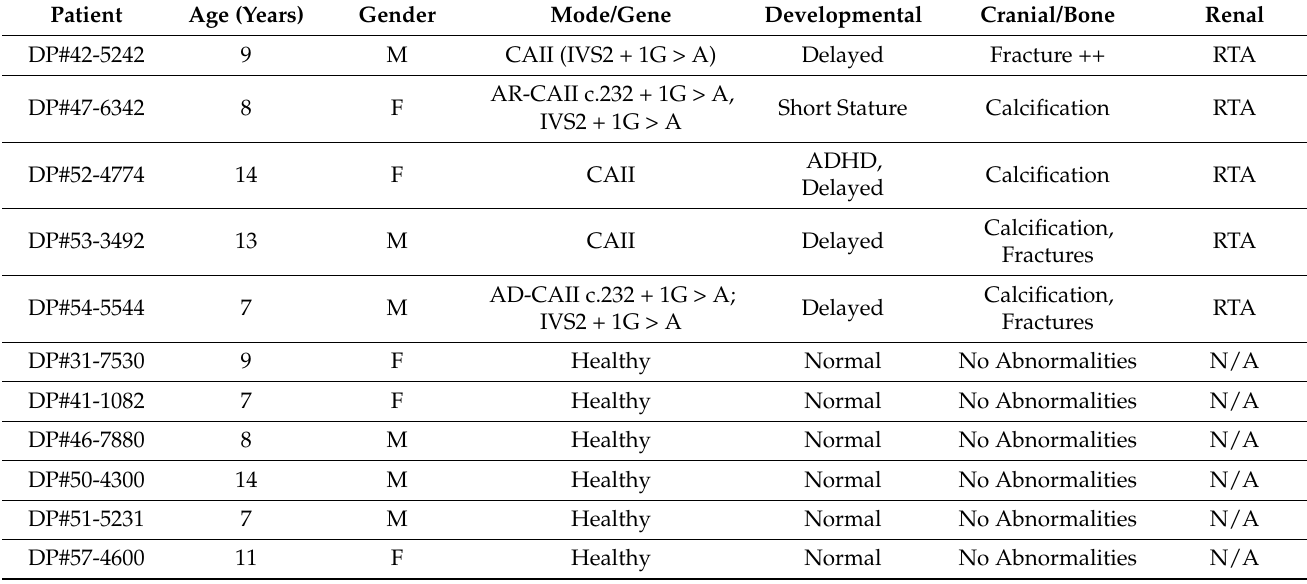
Table 1. Clinical characteristics of study